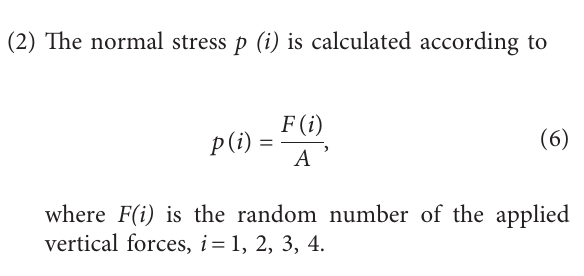
Figure 3: Calculation flow chart of the Monte Carlo